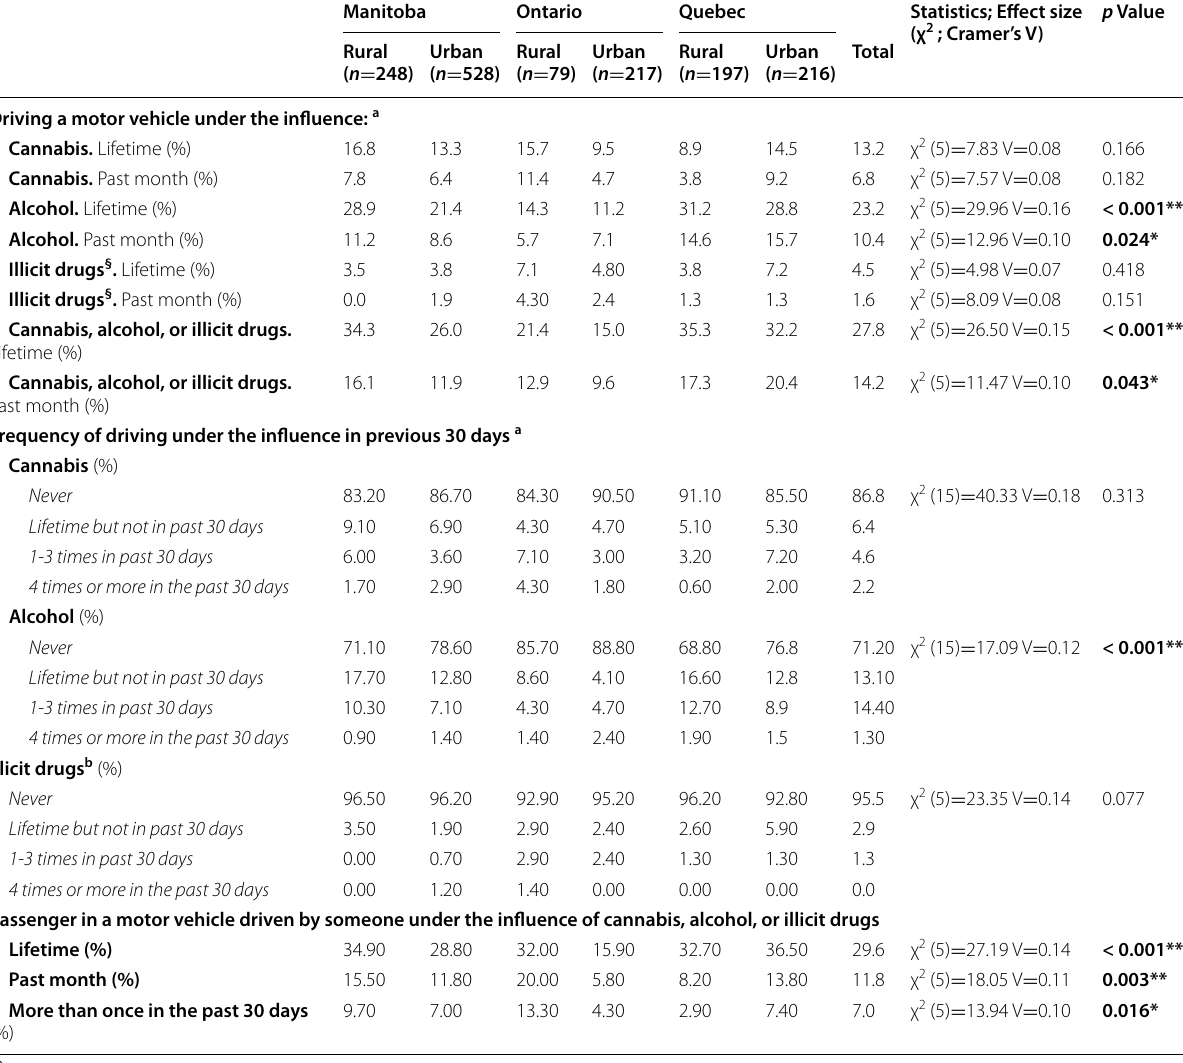
Table 3 Driving or being a passenger while driver is under the influence of cannabis, alcohol, or illicit drugs by province and rural/ urban